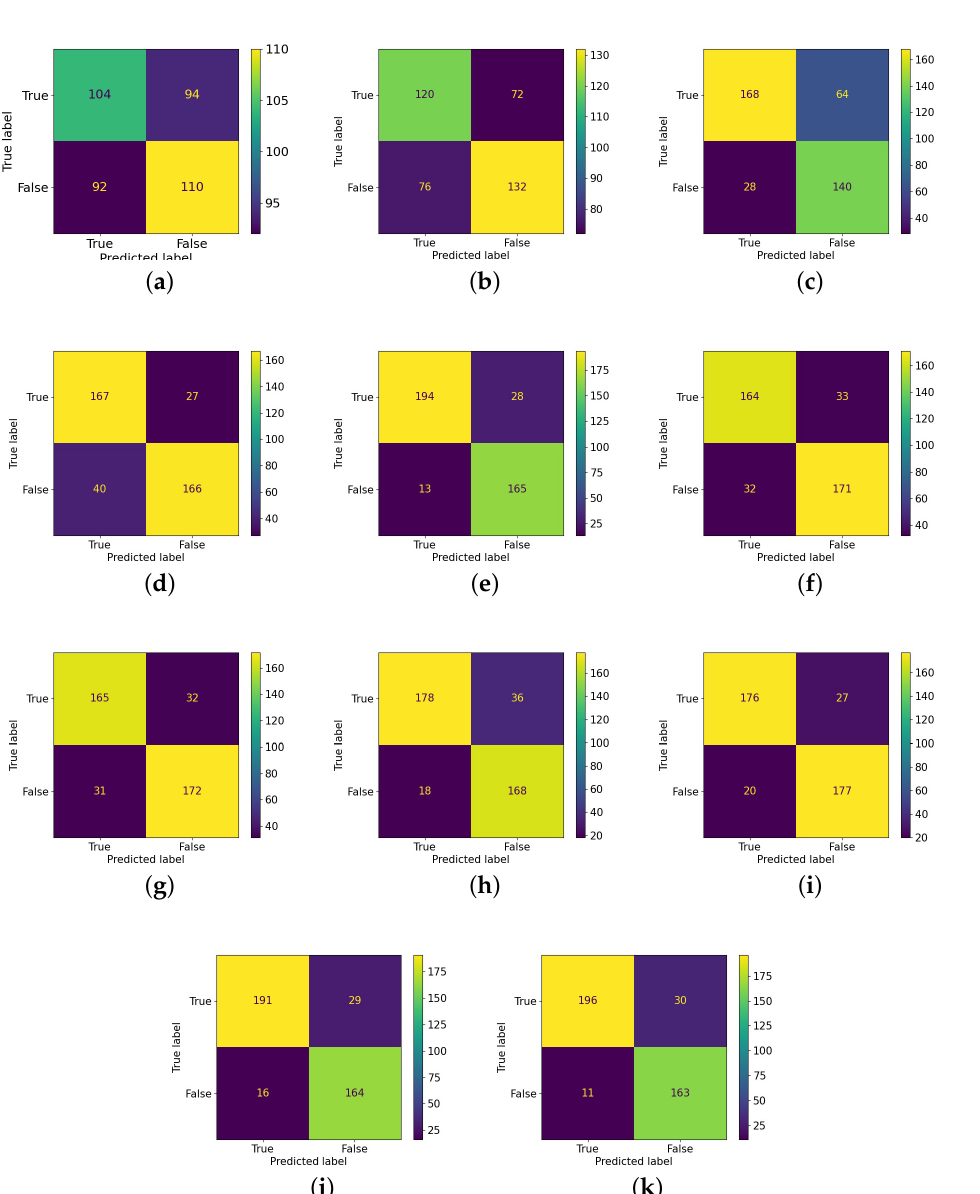
Figure 7. Confusion matrix of ( a )Spotfake [23]; ( b )EANN [21]; ( c ) SBERT-WK [41]; ( d ) COSMOS